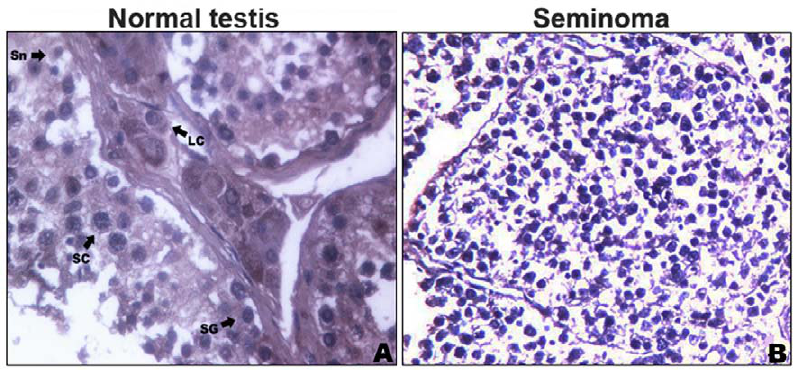
Figure 2. Immunohistochemical staining of RASSF1A in human testis cancer. Normal testis sample ( A ) and testis tumor with methylated RASSF1A ( B ). Normal testis section stained positively for RASSF1A. RASSF1A was mainly expressed in cytoplasm of the spermatogonia (SG), spermatocytes (SC), Sertoli cells (Sn) and Leydig cells (LC) of normal testis, while seminoma sample with methylated RASSF1A showed weak staining. Nuclei were stained with Hematoxlin.